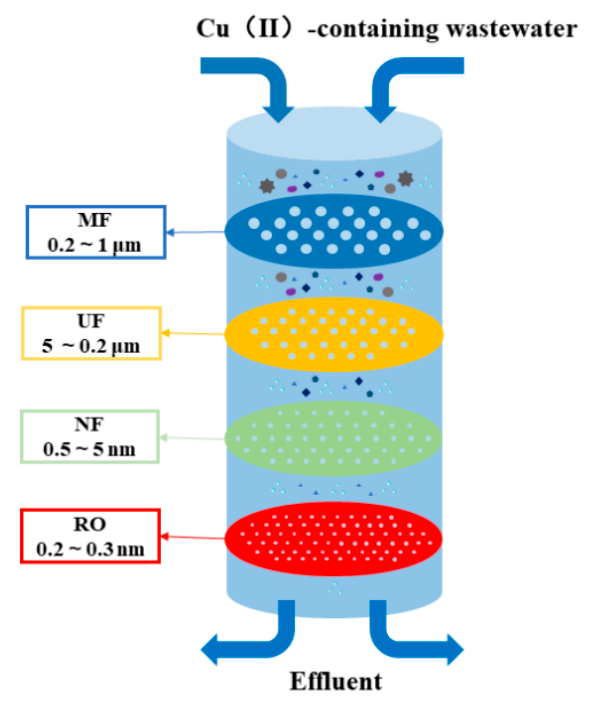
Figure 2. Membrane technology including MF, UF, NF, and RO.